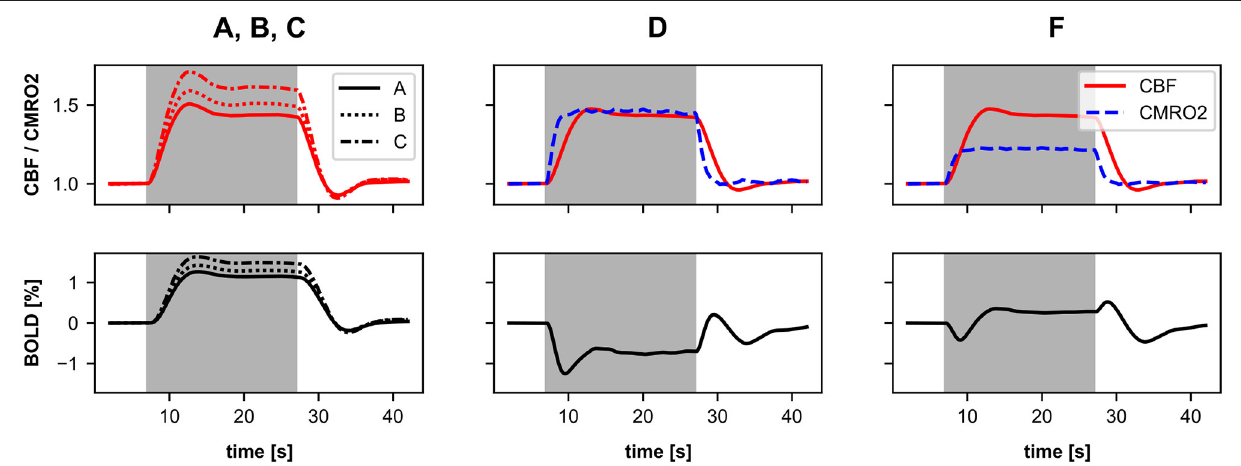
FIGURE 7 | Normalized CBF, CMRO2, and BOLD (relative change) responses of the different BOLD monitors ( A–C , left), ( D , mid), and ( F , right) including different source variables. The averaged recordings of 40 simulations with a 20 s stimulus pulse are shown. The background highlighted in gray indicates the time window of the active stimulus. Here, the firing rate of the Poisson neurons is increased by a factor of 1.2 for 20 s. For a more detailed description about the source variables see Section 4.3 and Table 1 . The BOLD monitors (A–C) using the classic Balloon model with a single CBF-driving input. The BOLD monitors (D–F) using the two-input Balloon model defined in this work with separately driven CBF and CMRO2. The responses of BOLD monitor E are shown in the Supplementary Figure 1 as they are almost identical to those of BOLD monitor (D)